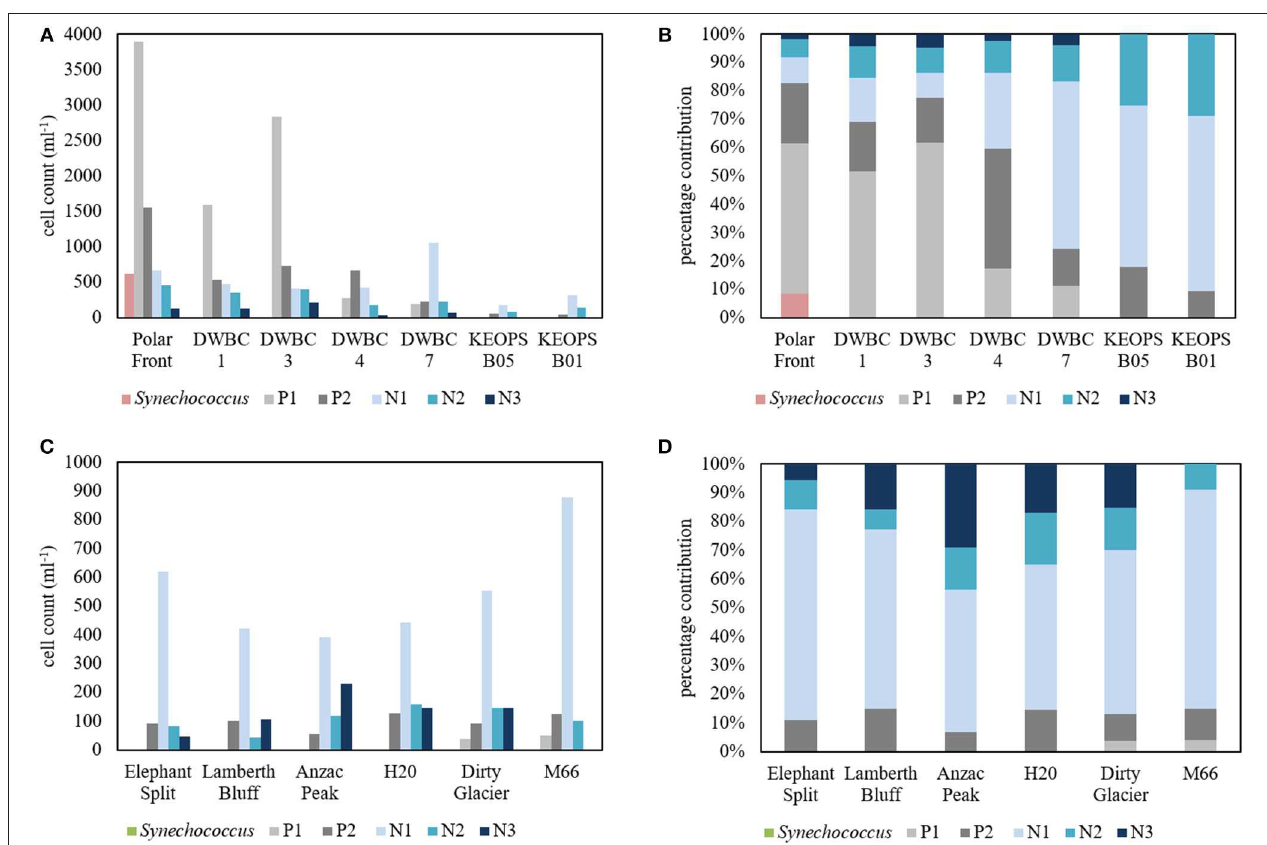
FIGURE 5 | Variability in the pico- ( Synechococcus , P1, and P2) and nanophytoplankton (N1, N2, N3) cell counts and community composition from flow cytometry measurements; (A) cell counts for all Transect B stations; (B) Percentage contribution of pico- and nanophytoplankton groups to total cell counts at stations along Transect B; (C,D) the same as (A,B) for Heard and McDonald Island stations. Note different y-axis scales for (A,C)